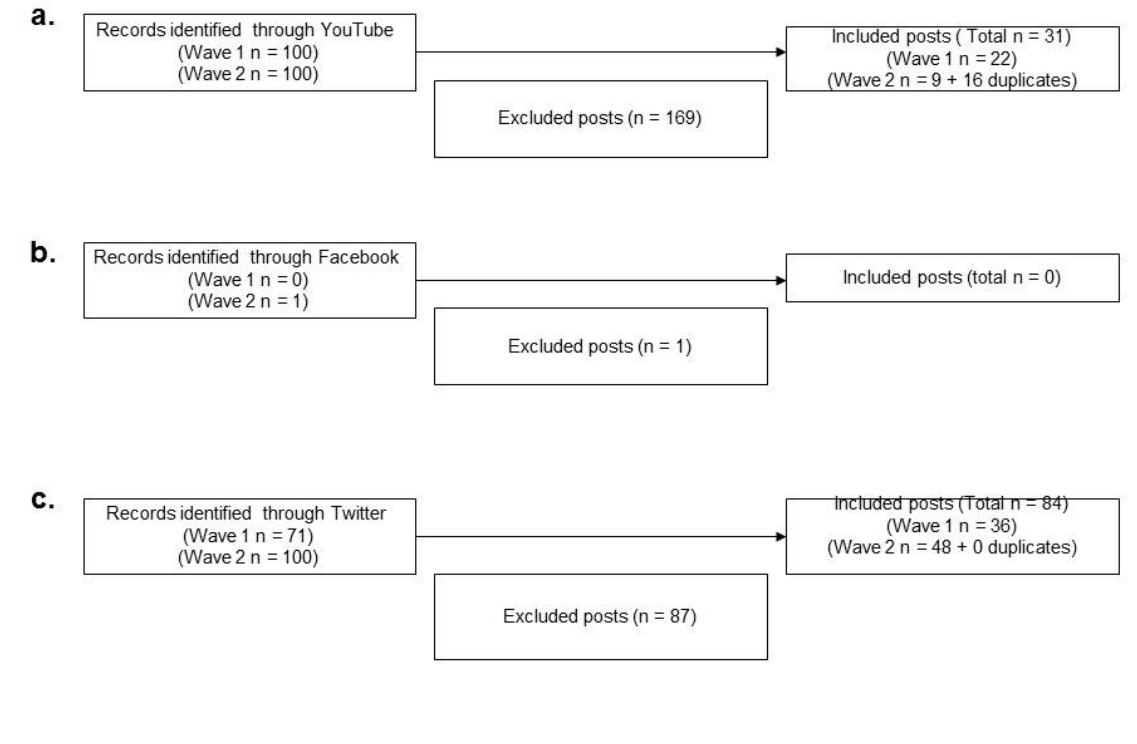
Figure 2. Flowcharts of the post selection: YouTube, Facebook, and Twitter. (a) YouTube flow chart; (b) Facebook flow chart; (c) Twitter flow